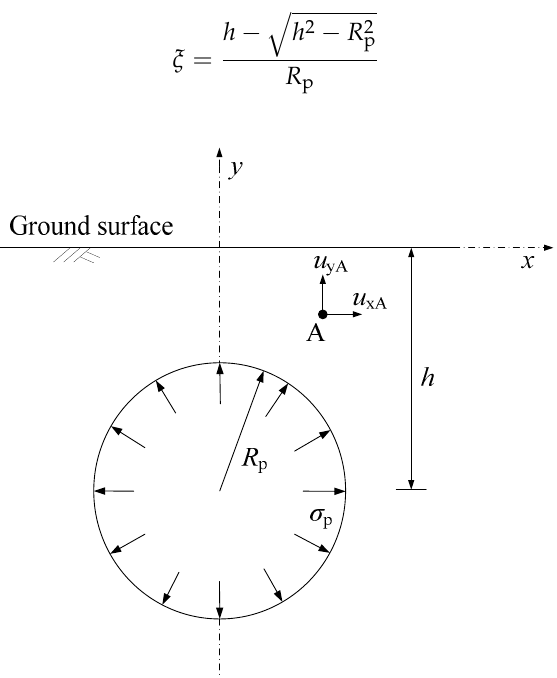
Figure 1. Illustration of a case with uniform stress applied at tunnel boundary (recreated based on Shen et al. [11], Wang et al. [68]).